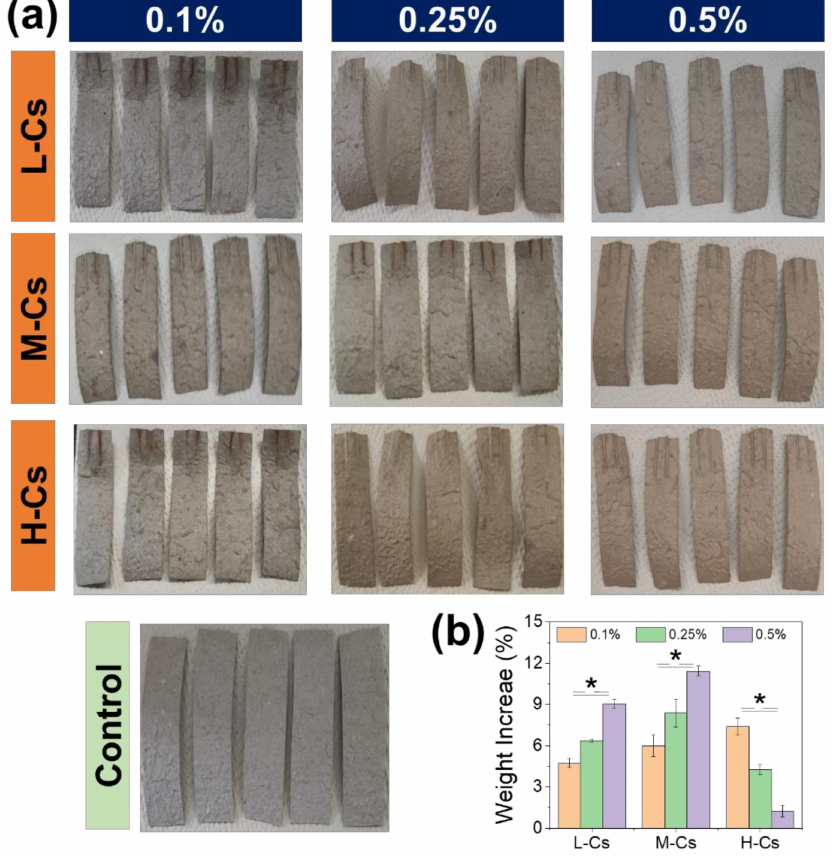
Figure 5. ( a ) Photographs of plant papers coated with chitosan with varying concentrations and molecular weights. ( b ) The increase in weight of plant papers after chitosan coating (* p <